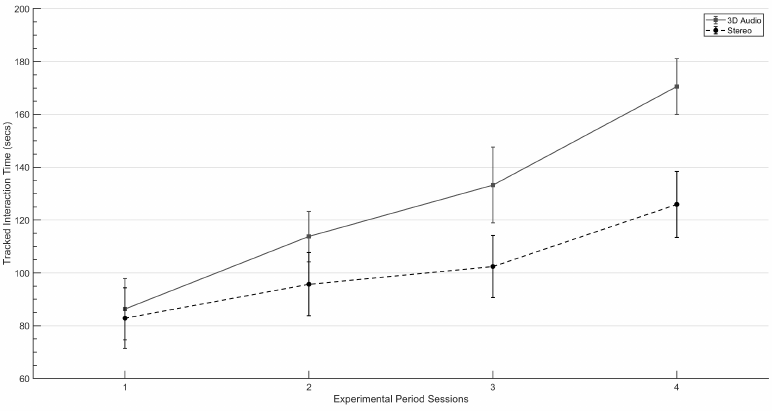
Figure 6. Mean tracked interactions times across all experimental sessions. The whiskers denote